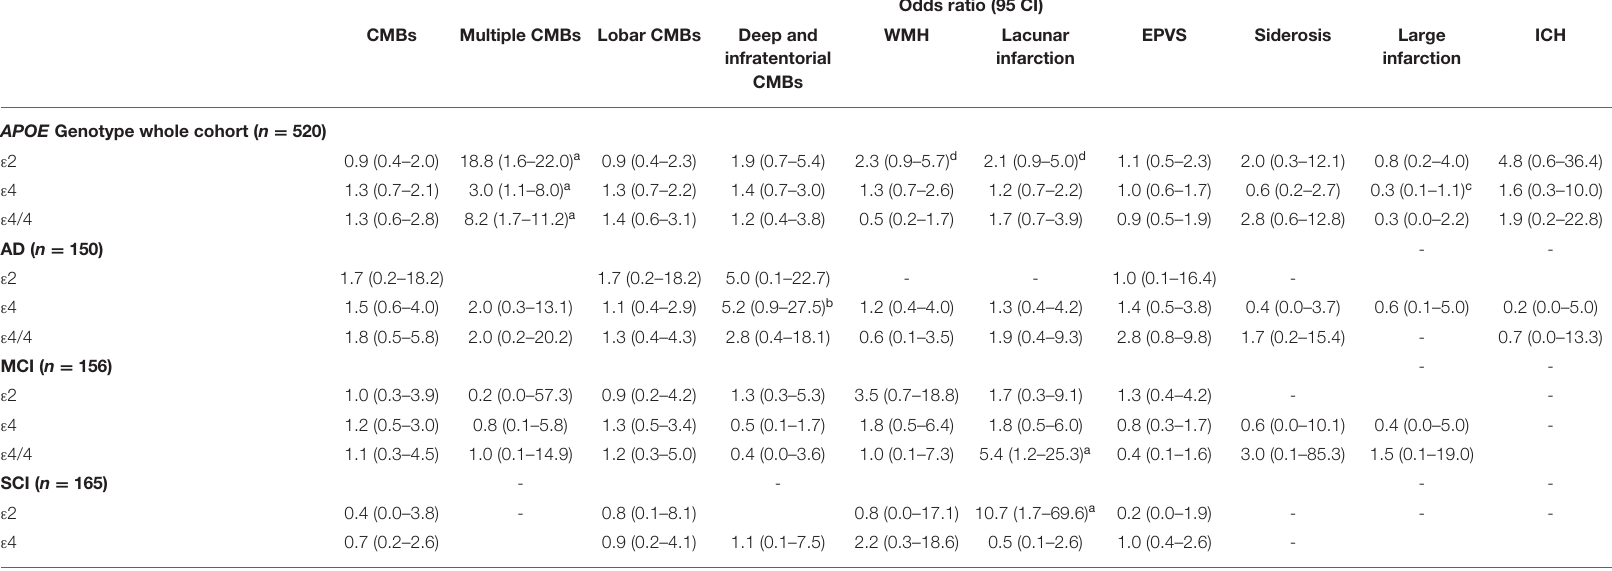
Multiple binary logistic regression analyses were performed with the APOE genotype as an independent variable and the dichotomized MRI markers as dependent variables. APOE ε 3/3 was used as a reference for all APOE genotypes. The model was controlled for age, gender, hypertension, hyperlipidemia, diabetes, and MRI field strength. APOE alleles were excluded from analysis if effect sizes were considered too small (e.g., no MRI marker); similarly “-” indicates too small effect size to be computed. Multiple CMBs = over 1 CMB. EPVS was dichotomized into 0 (score 0, 1, and 2), 1 (score 3 and 4). WMH are rated according to the Fazekas scale and dichotomized as 0 (score 0 and 1), 1 (score 2 and 3). AD, Alzheimer’s disease; CMB, Cerebral microbleeds; EPVS, Enlarged Perivascular Spaces; ICH, Intracerebral Hemorrhage; MCI, Mild cognitive Impairment; SCI, Subjective cognitive impairment; WMH, White